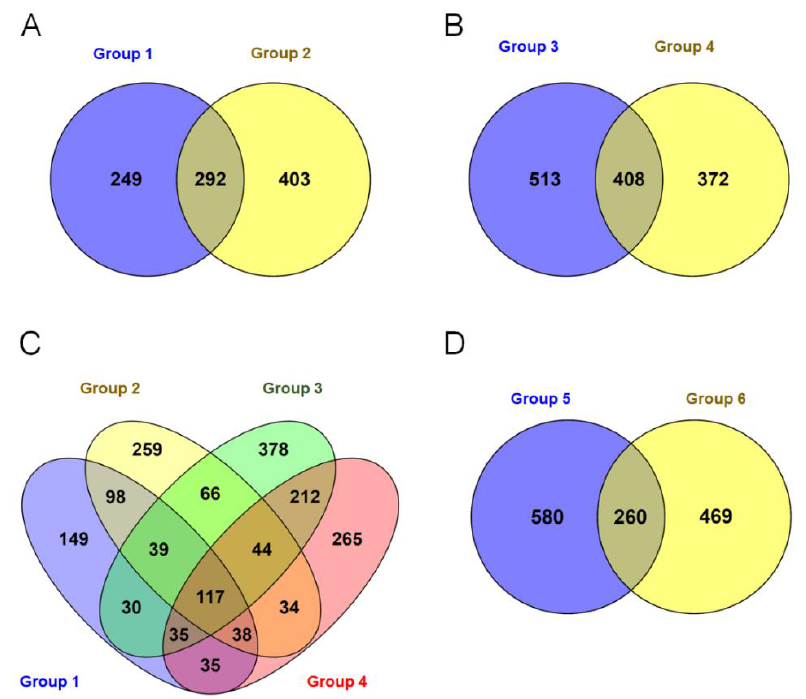
Figure 3. Differential expression of genes (DEGs) of groundnut genotype under control and infected conditions in response to Aspergillus flavus . ( A ) Group 1: moderately resistant J 11(I) vs. resistant (ICGV 91278, ICGV 91315, ICGV 93305, ICGV 91284, ICGV 94379, ICGV 91324) infected condition, Group 2: susceptible JL 24 vs. resistant (ICGV 91278, ICGV 91315, ICGV 93305, ICGV 91284, ICGV 94379, ICGV 91324) in infected condition, ( B ) Group 3: resistant J 11(C) vs. resistant (ICGV 91278, ICGV 91315, ICGV 93305, ICGV 91284, ICGV 94379, ICGV 91324) in control conditions, and group 4: susceptible JL 24 vs. resistant (ICGV 91278, ICGV 91315, ICGV 93305, ICGV 91284, ICGV 94379, ICGV 91324) under control conditions. ( C ) Number of differentially expressed transcripts between group 1, group 2, group 3 and group 4 and ( D ) group 5: susceptible JL 24 vs. (J 11, ICGV 91278, ICGV 91315, ICGV 93305, ICGV 91284, ICGV 94379, ICGV 91324 under control conditions, group 6: susceptible JL 24 vs. (J 11, ICGV 91278, ICGV 91315, ICGV 93305, ICGV 91284, ICGV 94379, ICGV 91324) in infected condition.